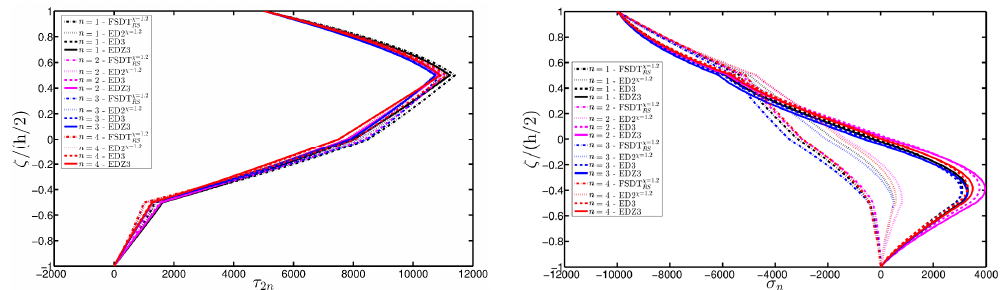
Figure 26. Through-the-thickness profiles of stress components [Pa] for the CCCF doubly-curved panel of revolution computed at the point C for different HSDTs. The effect of the damage is investigated by varying the parameters of the function Gau-6.